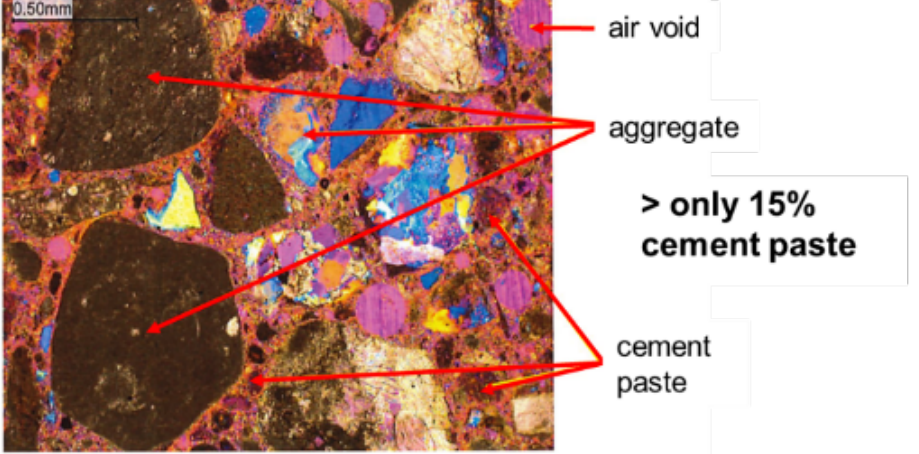
Figure 2. Thin section to determine the content of cement